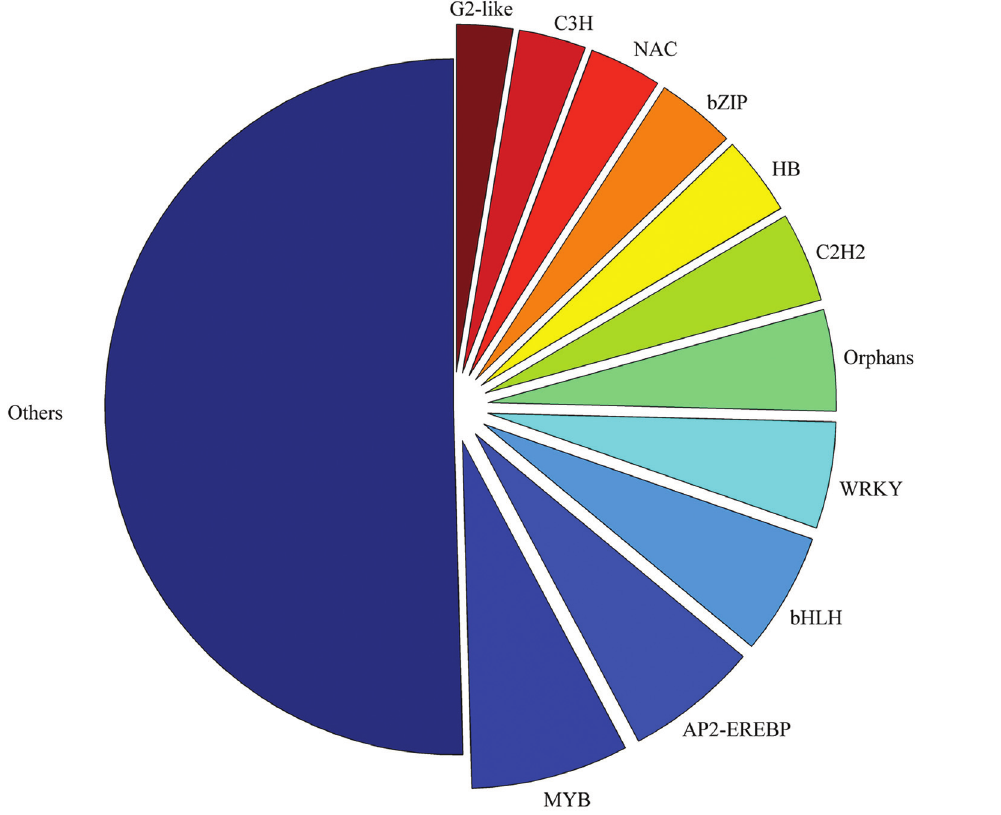
Figure 4 - Distribution of transcription factor genes in the differentially expressed Medicago ruthenica transcriptome sequences. The transcription factor genes were identified and classified using iTAK. The pie plot shows that MYB, AP2/ERF, bHLH, and WRKY are the largest TF family genes expressed in the Medicago ruthenica abiotic stress